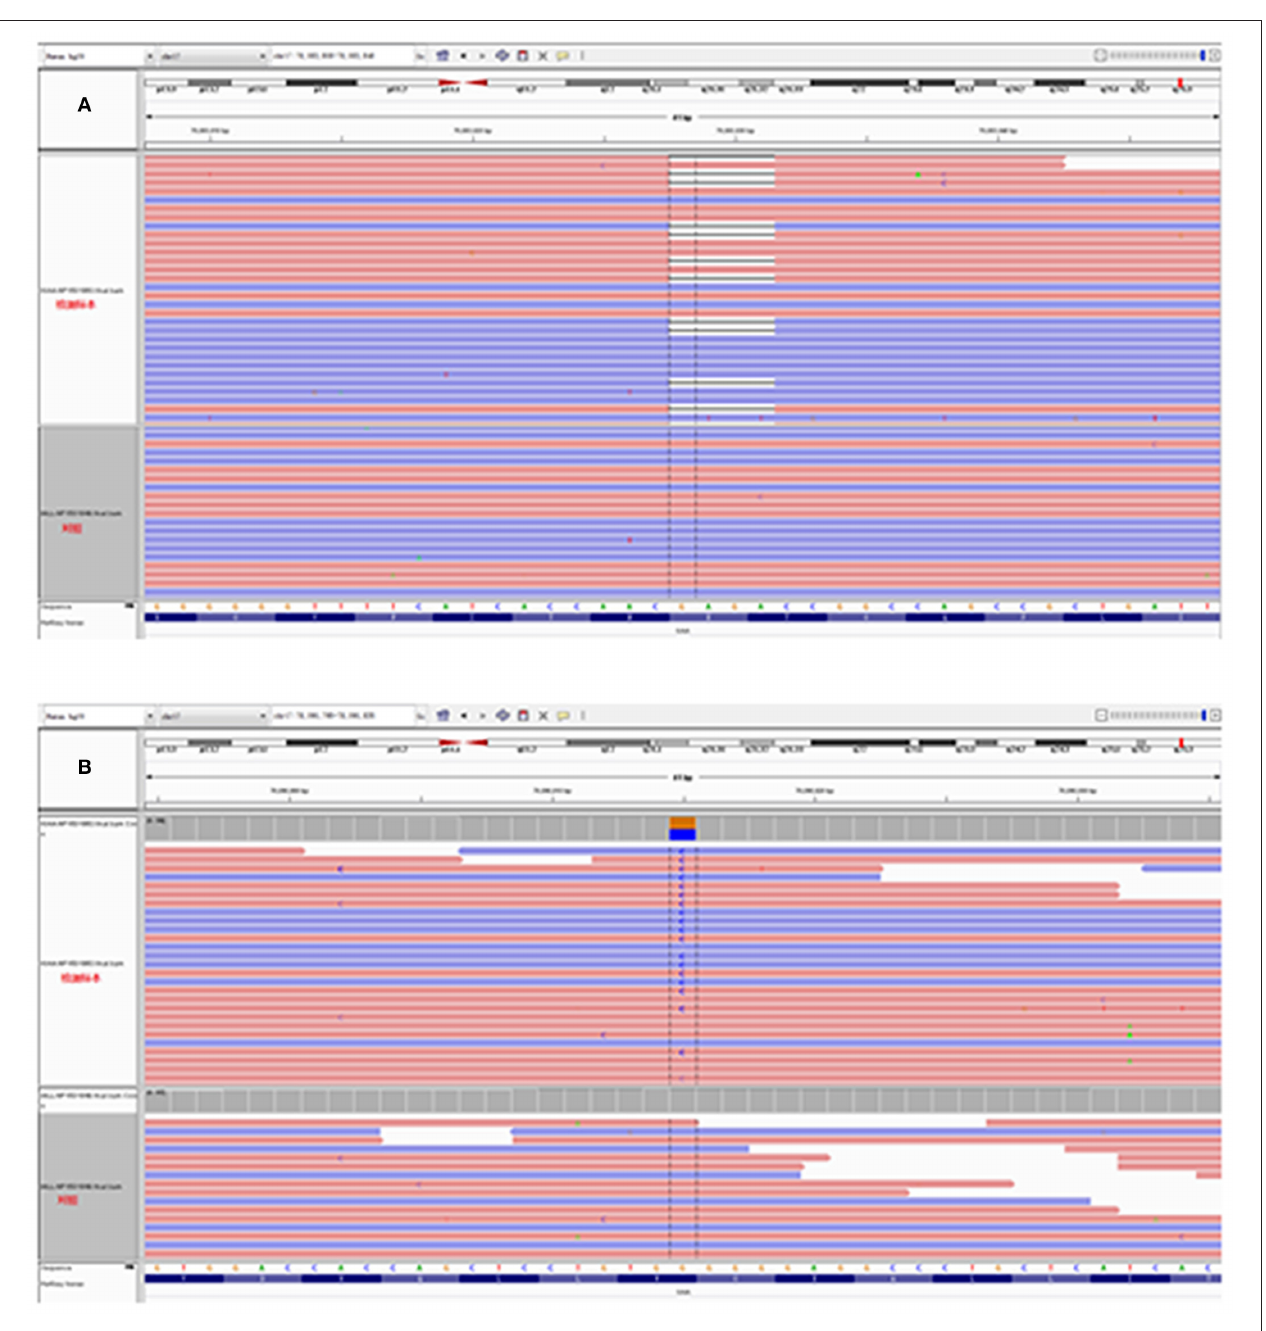
FIGURE 2 | Molecular DNA analysis of the patient. (A,B) Heterozygous mutations at c.1411_1414del (p.Glu471ProfsTer5) and c.2238G > C (p.Trp746Cys) were detected in the patient.